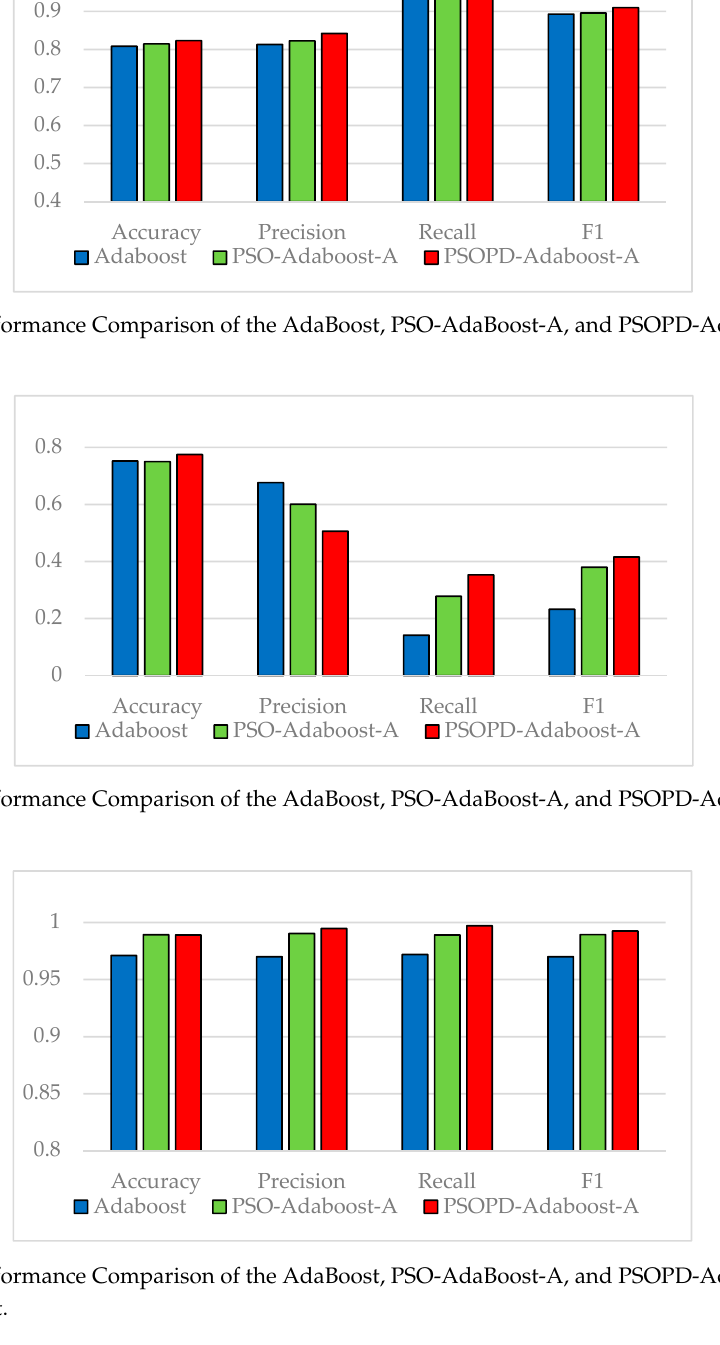
Figure 13. Performance Comparison of the AdaBoost, PSO-AdaBoost-A, and PSOPD-AdaBoost-A on Statlog Dataset.